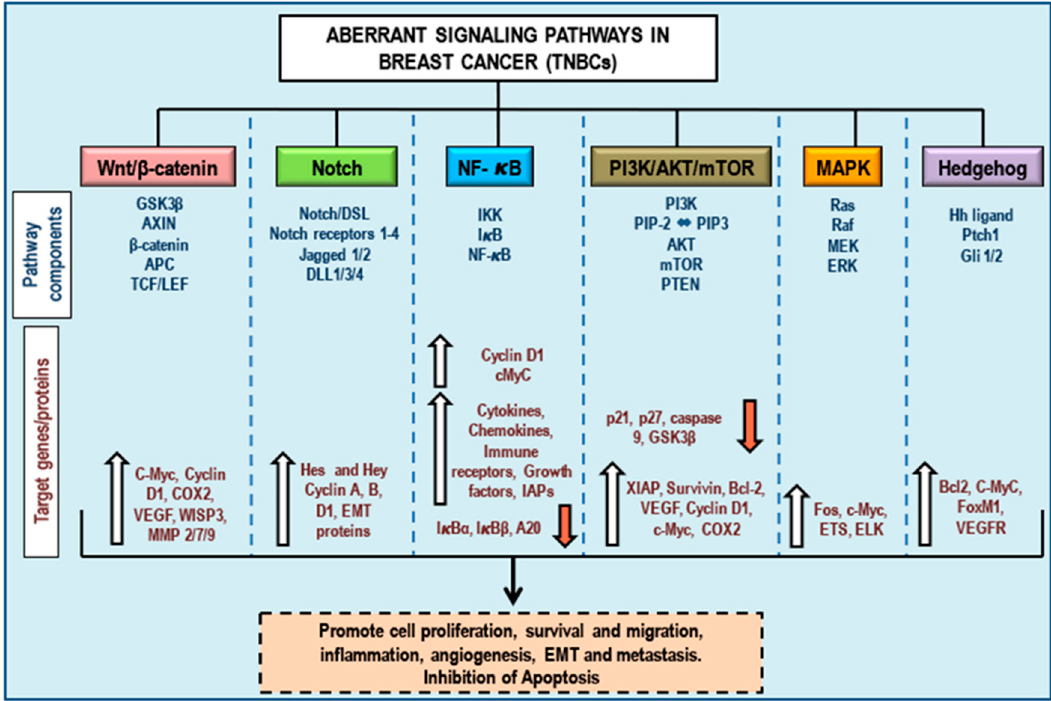
Figure 1. Oncogenic signaling in triple-negative breast cancers (TNBCs). Aberrant signaling pathways (Wnt/ β -catenin, Notch, NF- κ B, PI3K/AkT/mTOR, MAPK and Hedgehog) significant in TNBCs and specific pathway-associated components, target genes, and the dysregulated proteins involved in the various signaling pathways leading to cancer progression by supporting cell proliferation, survival and migration, inflammation, angiogenesis, epithelial-mesenchymal transition (EMT) and metastasis, and inhibition of apoptosis. The upward white arrows indicate activation/upregulation while the downward red arrows indicate inhibition/downregulation.